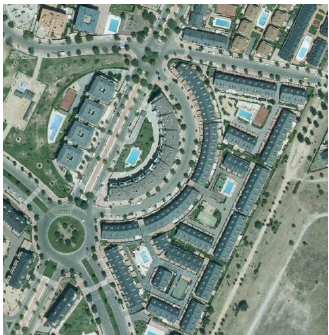
Figure 10. Mercator projection 42º